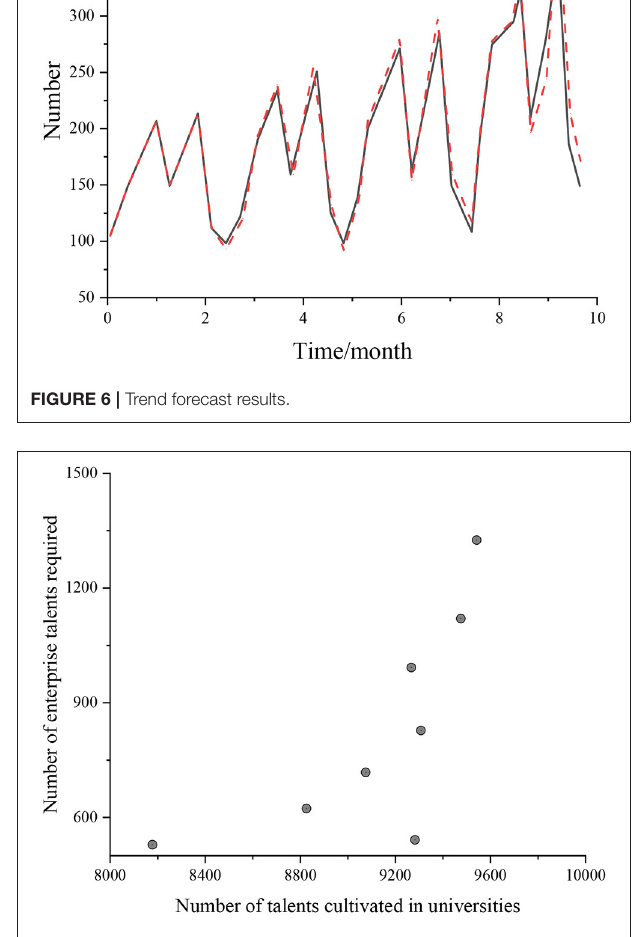
FIGURE 7 | Scattered chart of the number of talents cultivated in universities and the number of talent demand of enterprises.